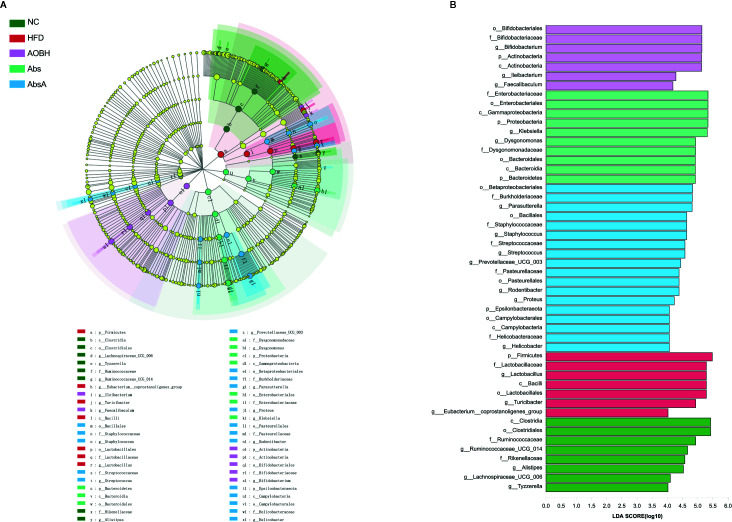
The AOB effect on the composition of gut microbiota. (A) Cladogram for taxonomy generated through LEfSe analysis showing prominent shifts in the gut microbiota in each group (score > 4). (B) Linear discriminant analysis (LDA) scores (log10) of taxa (score > 4).